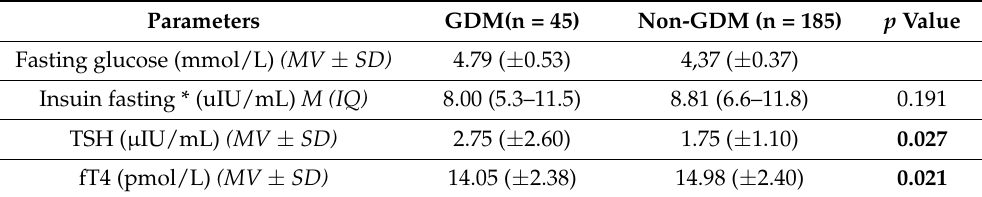
Table 4. Biochemical parameters in the study